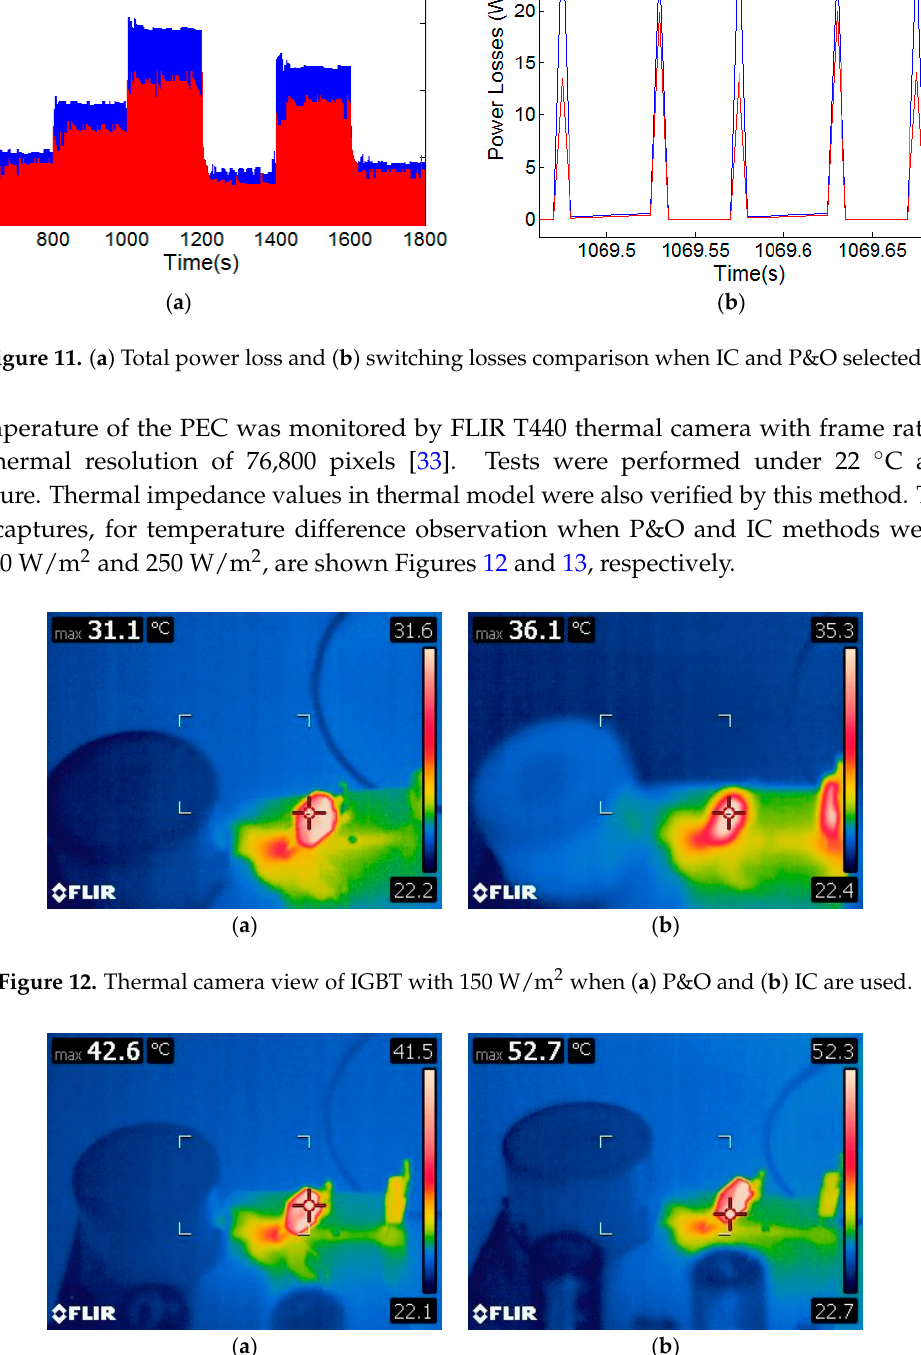
Figure 11. ( a ) Total power loss and ( b ) switching losses comparison when IC and P&O selected.